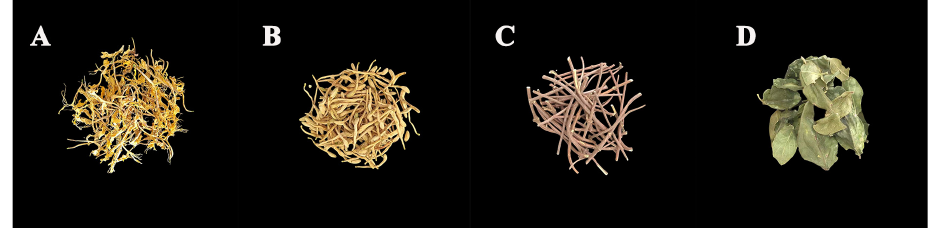
Figure 1. Phenotypes of different tissues of LJT. ( A ) flowers. ( B ) flower buds. ( C ) stems. ( D ) leaves.